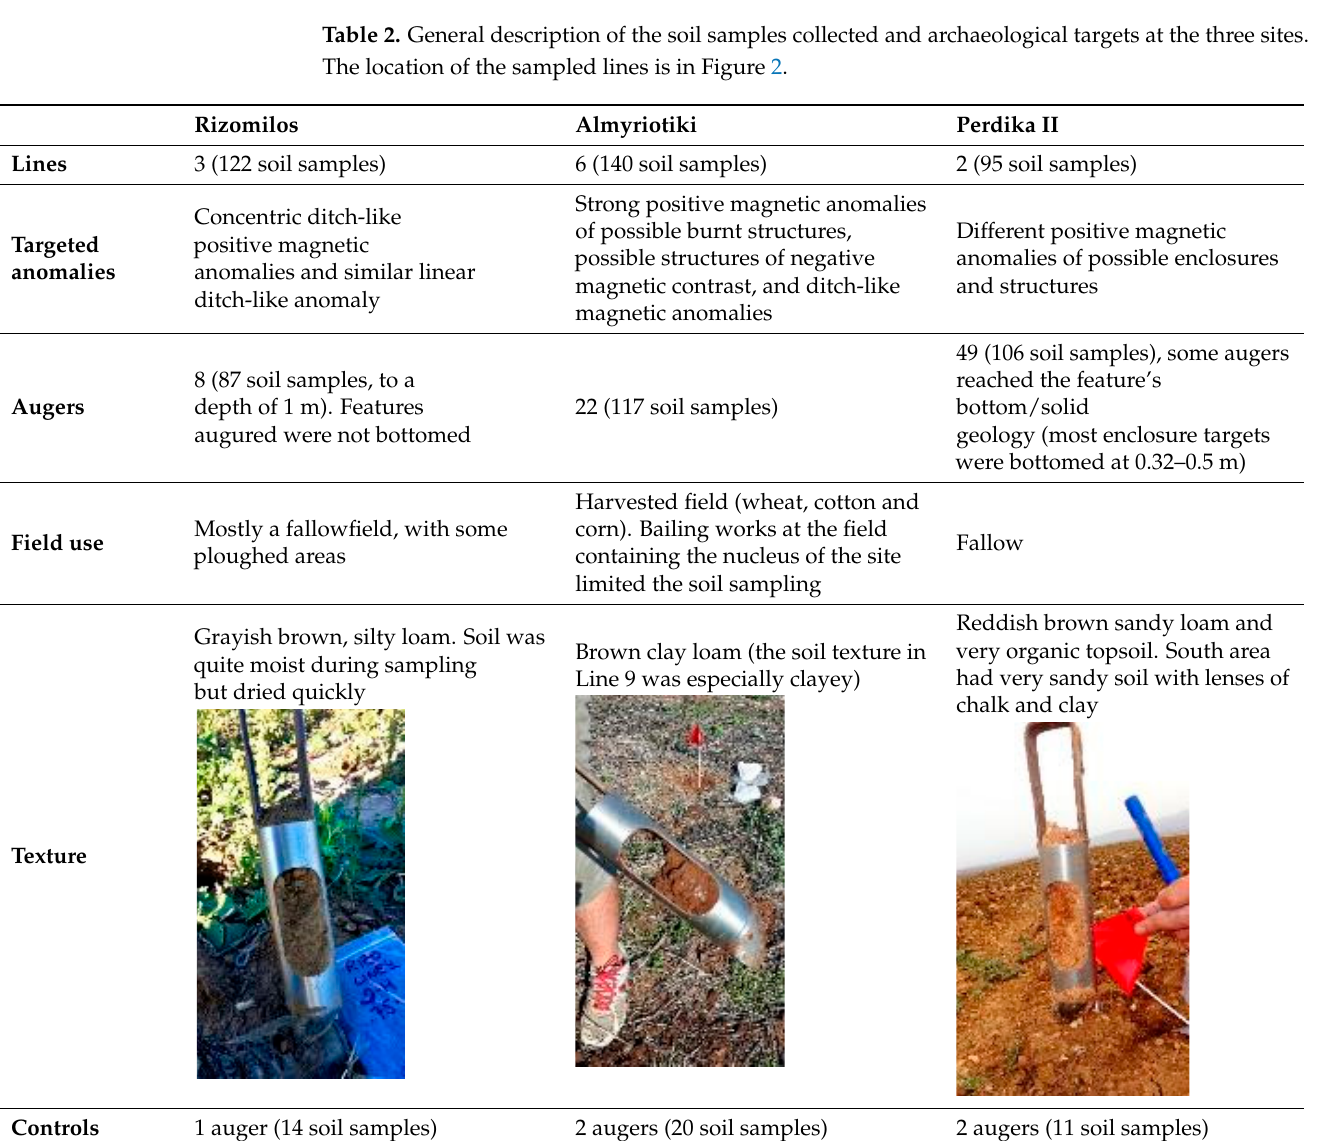
Table 2. General description of the soil samples collected and archaeological targets at the three sites. The location of the sampled lines is in Figure 2.